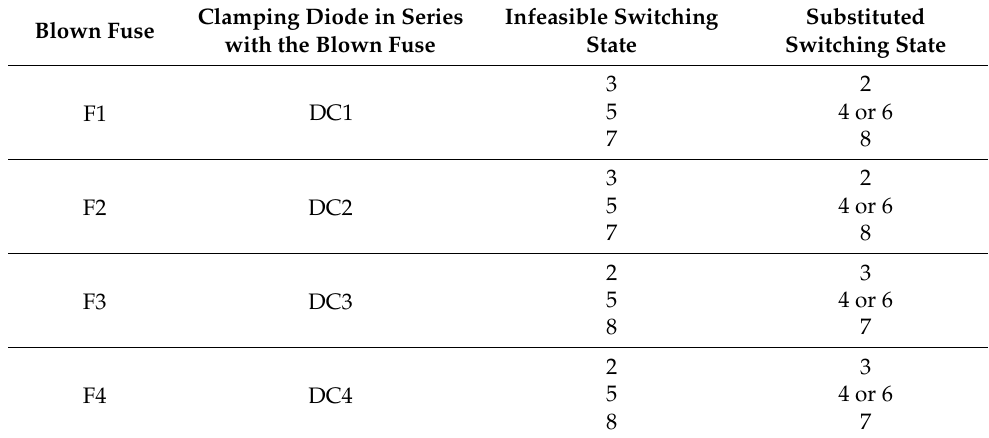
Table 4. Modification of the infeasible switching states to ensure service